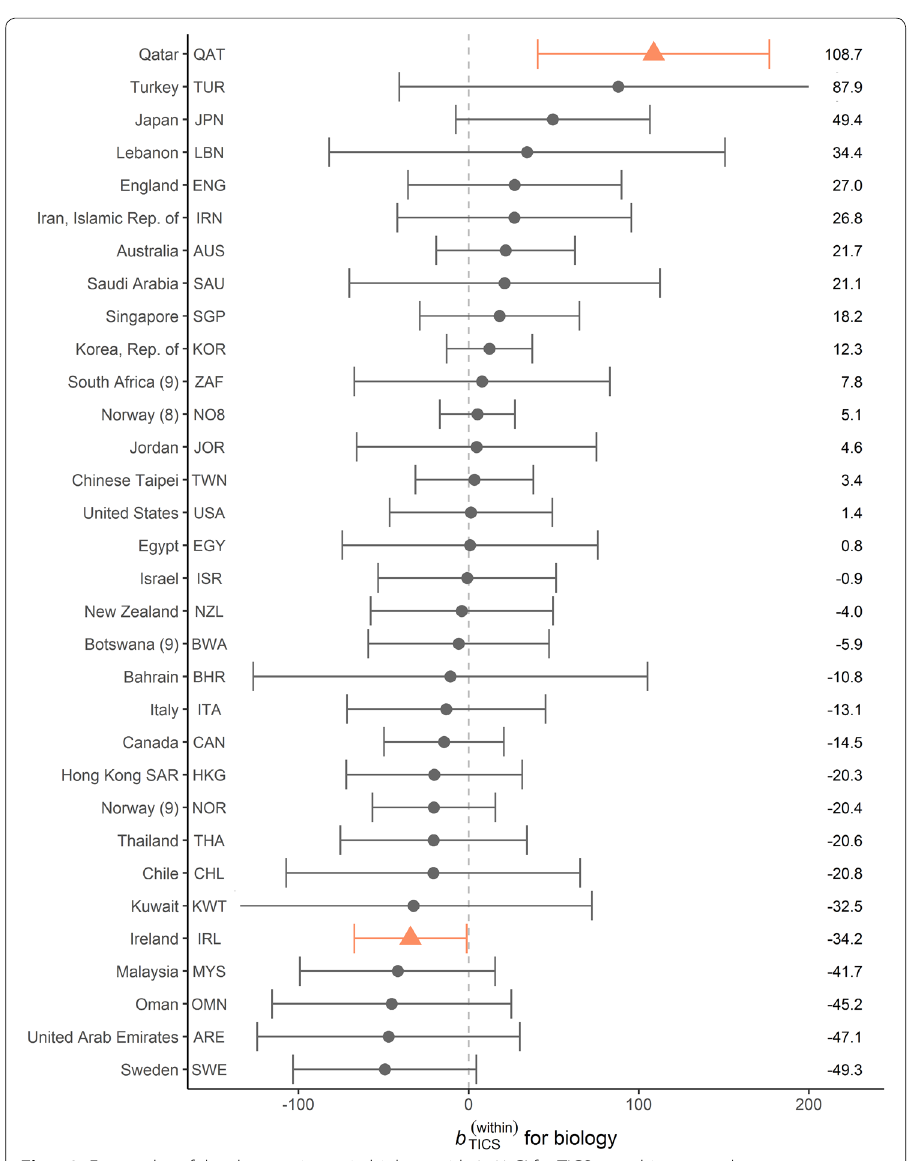
Fig. 10 Forest plot of the slope estimate in biology with 95% CI for TICS on achievement by